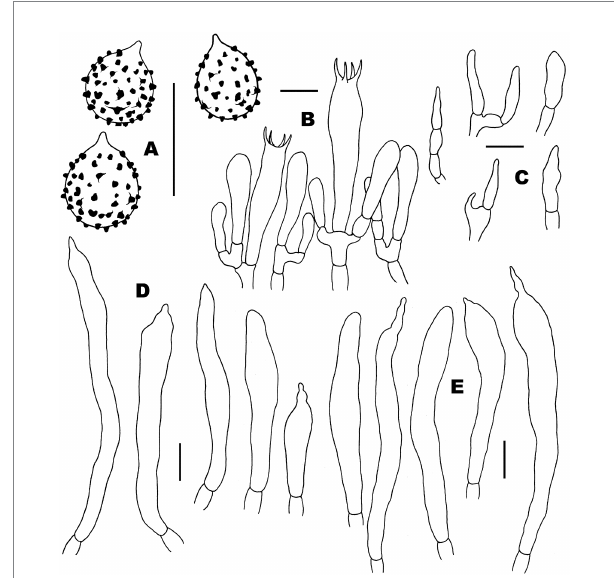
FIGURE 8 Microscopic features of Russula subatropurpurea (FHMU5454). (A) Basidiospores. (B) Basidia and basidiola. (C) Marginal cells. (D) Pleurocystidia. (E) Cheilocystidia. Scale bars = 10 μ m. Drawings by Y. X.Han.